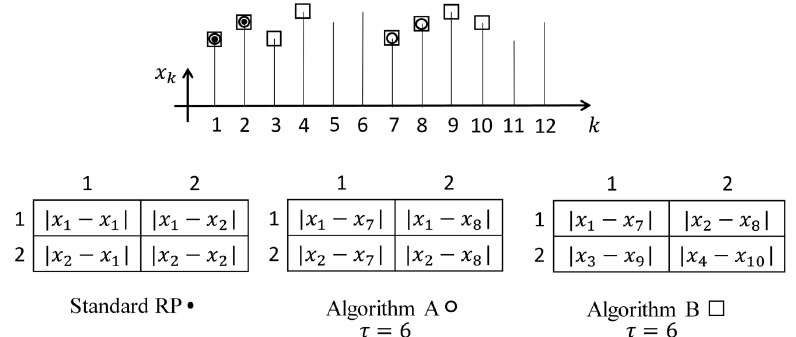
Figure 3. Figure showing 3 different recurrence plot generation algorithms. Standard recurrence plot, Algorithm A corresponds to a recurrence relationship involving non-uniform time delay with time delay τ + / − 1, Algorithm B corresponds to the recurrence relationship involving purely non-uniform time delays τ